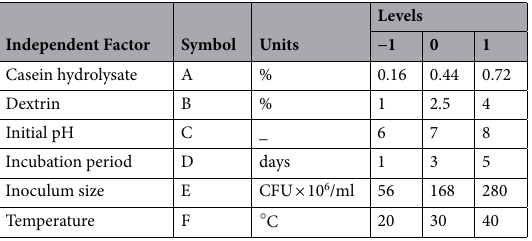
Table 1. Summary of PBD for AuNPs biosynthesis, using Bacillus subtilis NRC1 extracellular